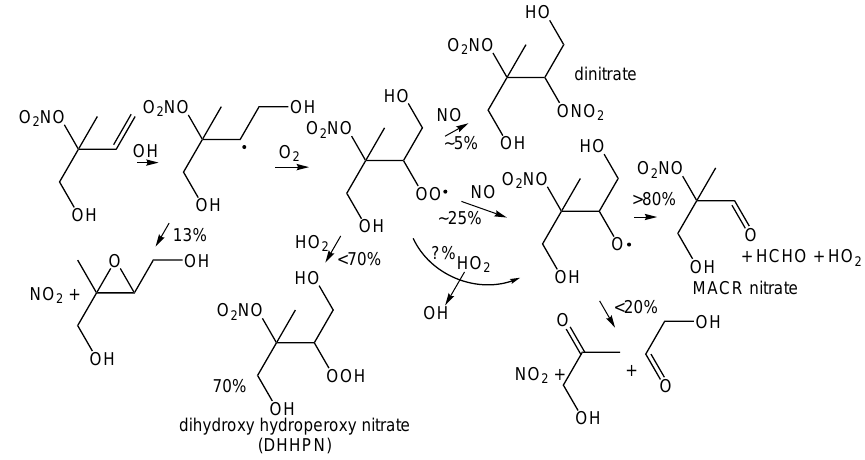
Figure 11. Possible oxidation mechanism for 1,2-IN with γ = 0 .